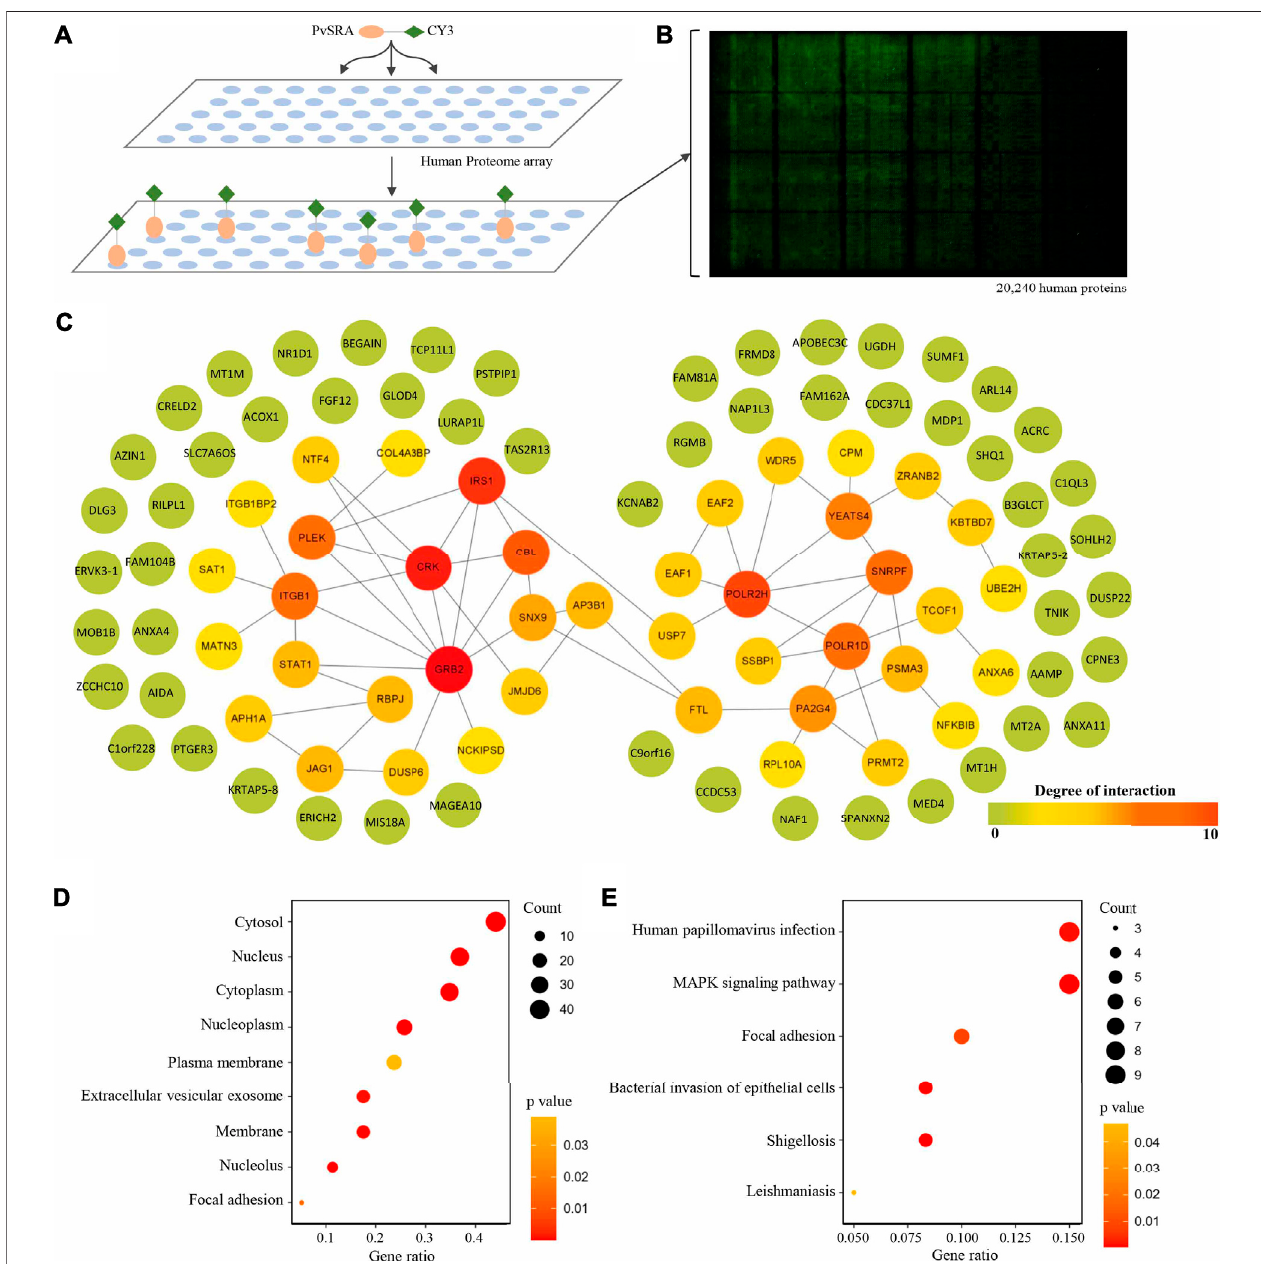
FIGURE 4 | Identi fi cation of PvSRA substrates. (A) Overall scheme to identify the PvSRA substrates using HuProt arrays. PvSRA labeled with CY3 was added to the array, whereas BSA labeled with CY3 was taken as negative control. (B) A representative image of the HuProt array. The reaction between PvSRA and the immobilized protein emits a fl uorescent signal. (C) PPI network image of the PvSRA substrates. The network was drawn by using STRING program, and the degree of interaction was calculated by Cytoscape software. (D) GO enrichment analysis of the PvSRA substrates. (E) KEGG pathway enrichment analysis of the PvSRA